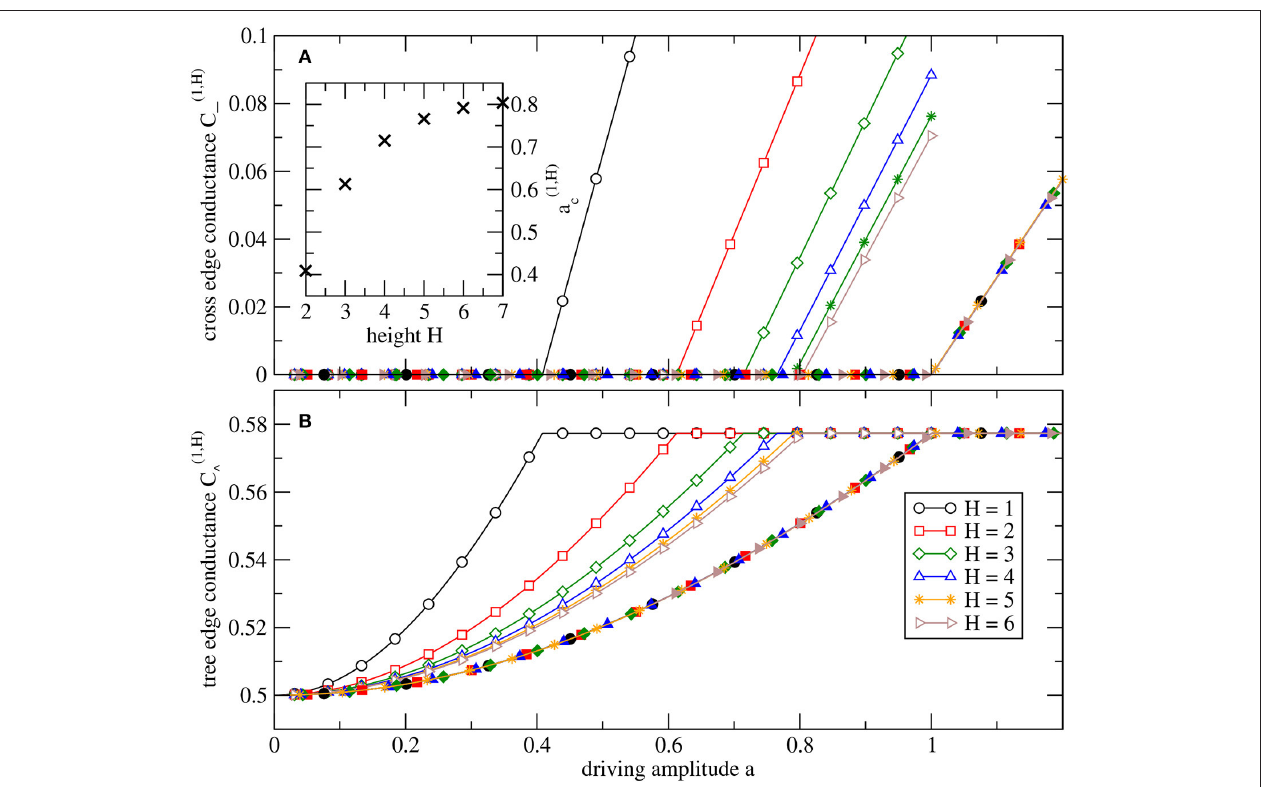
FIGURE 4 | Parameter dependence of stationary conductances in the top triangle of systems with height H . Open symbols denote in (A) the conductance of the root’s tree edges, C (1, H ) , and in (B) the conductances of the root’s cross-edge, C (1, H ) ∧ critical value a (1, H ) c . The inset in (A) shows the critical values a (1, H ) c . For height H , the system has N